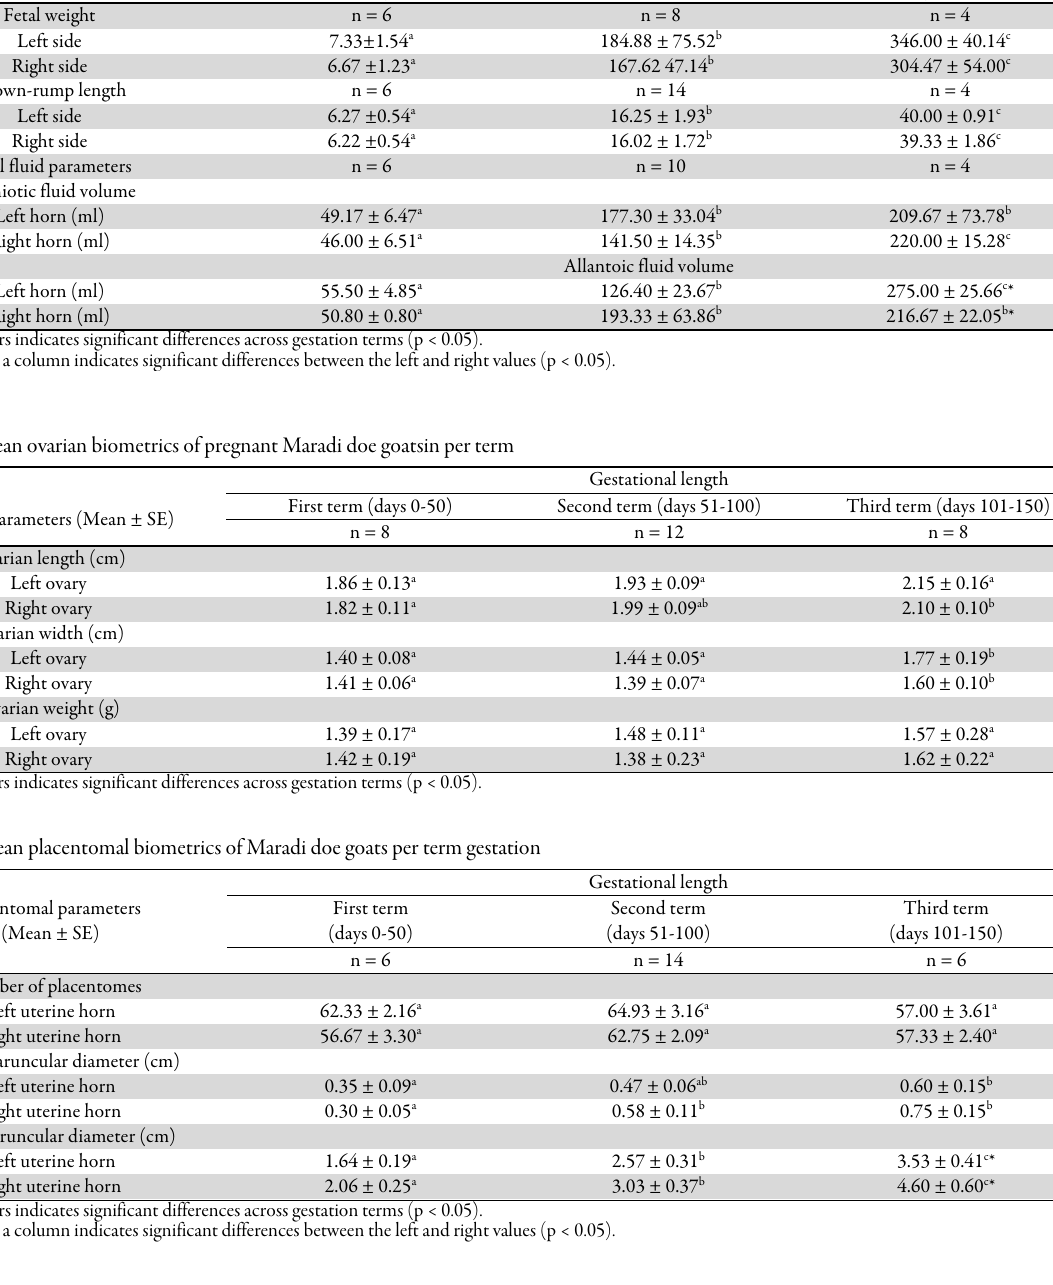
Table 2.The mean fetal biometrics of pregnant Maradi goats per term Fetal biometrics (Mean ± SE)